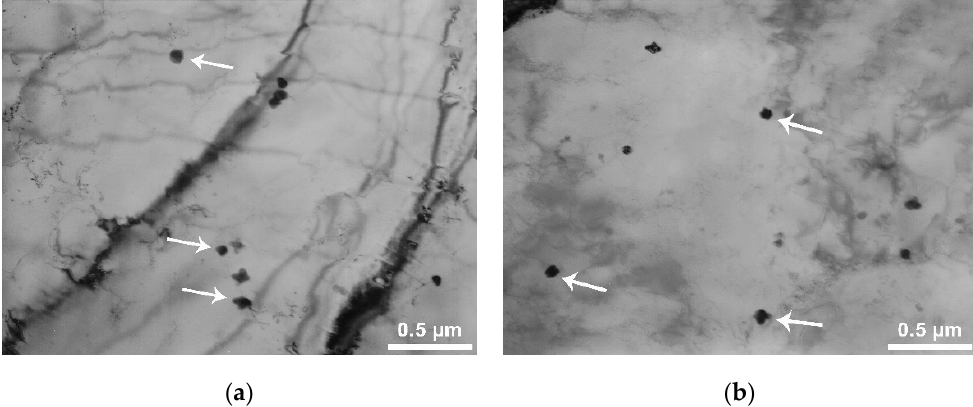
( d ) Figure 7. Dark-field image in reflections of nanosized carbonitrides (steel No 5): ( a ) Formed in